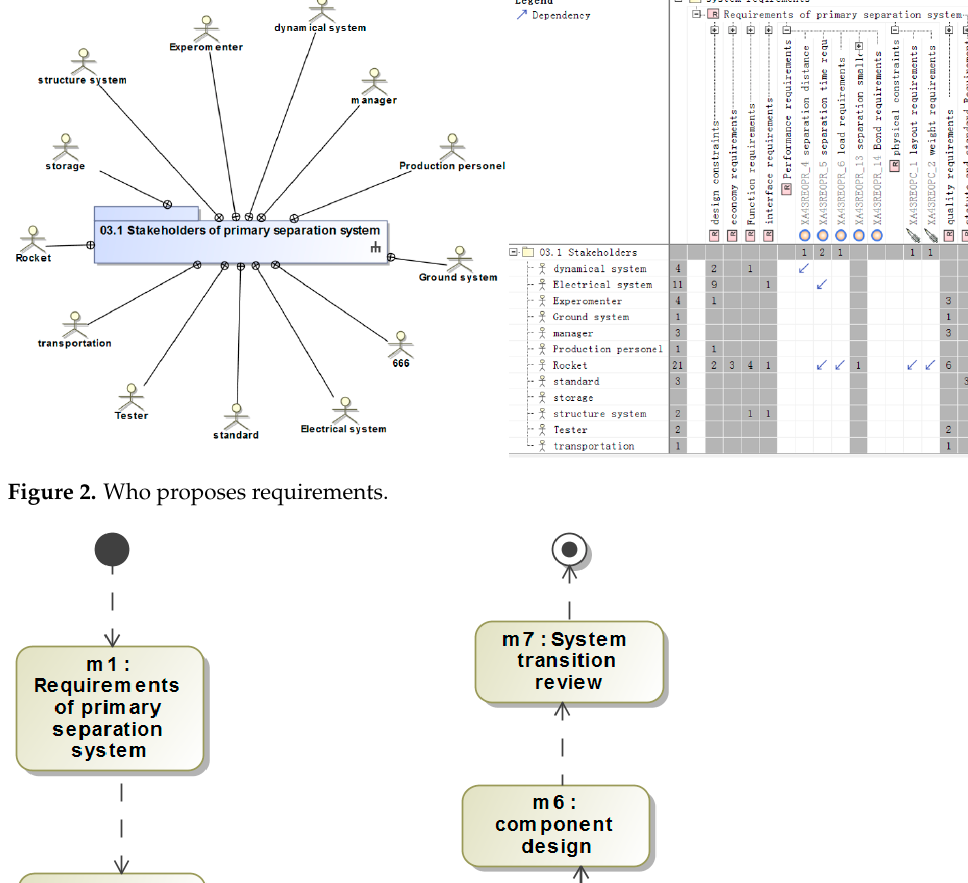
Figure 4. Where requirements are proposed.